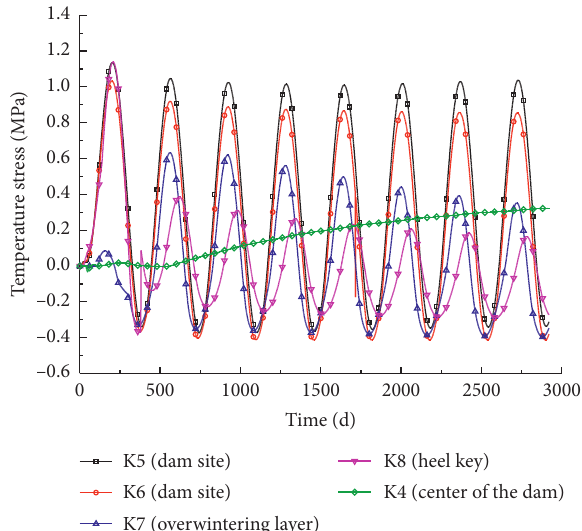
Figure 12: Temperature stress duration curves of different key point of dam